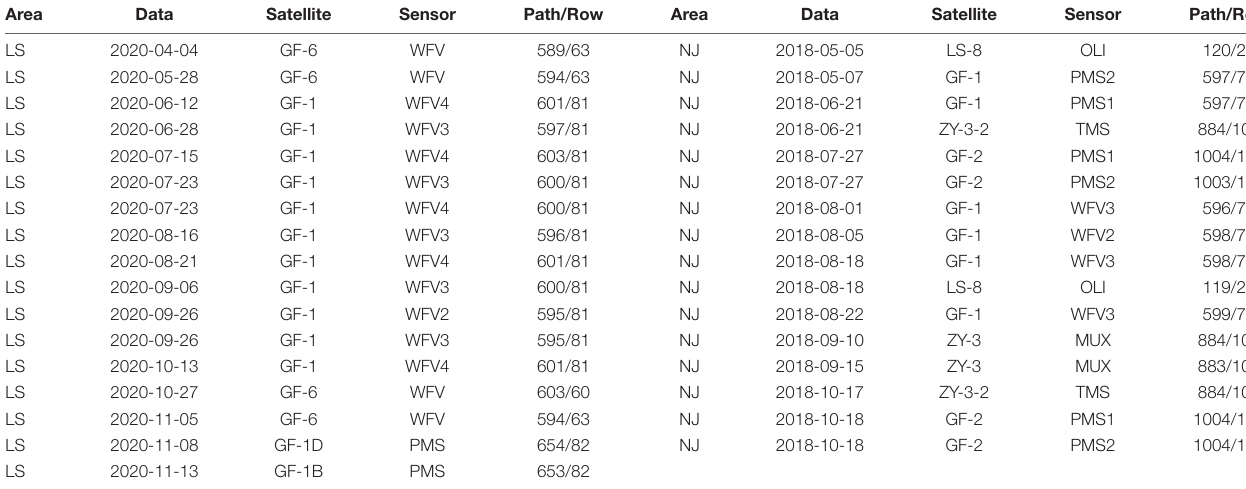
FIGURE 2 | Detailed types of soil profile in Songnen Plain (soil depth: 0-300 cm). TABLE 3 | List of satellite imagery collected in Nenjiang County and Lishu